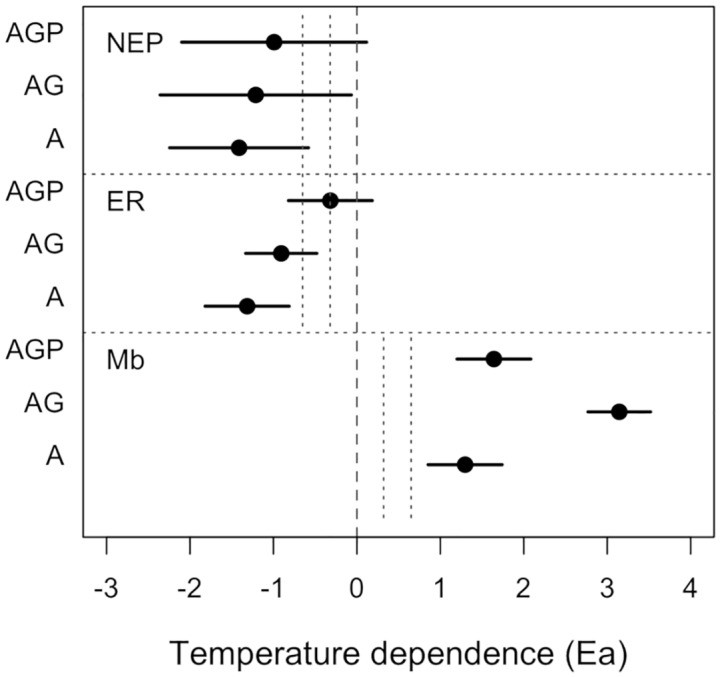
Comparison of estimated temperature dependences of phytoplankton biomass (MB), NEP, and ER for communities with algae only (A), algae and grazers (AG), and algae, grazers, and predators (AGP).Composite estimates of temperature dependences are as shown in Figs 2A and 5 (following Methods, Eq 14). No temperature dependence is indicated by the dashed line, and the vertical gray dotted lines indicate 0.65 and 0.32 eV, expected temperature dependences of algal photosynthesis and respiration, and −0.65 and −0.32 as expectations for the temperature dependence of phytoplankton total biomass. Data for these figures may be found at https://doi.org/10.5281/zenodo.2652579 in GarzkeAllwks.csv. A, algae only; AG, algae and grazers; AGP, algae, grazers, and predators; ER, ecosystem respiration; NEP, net ecosystem production.